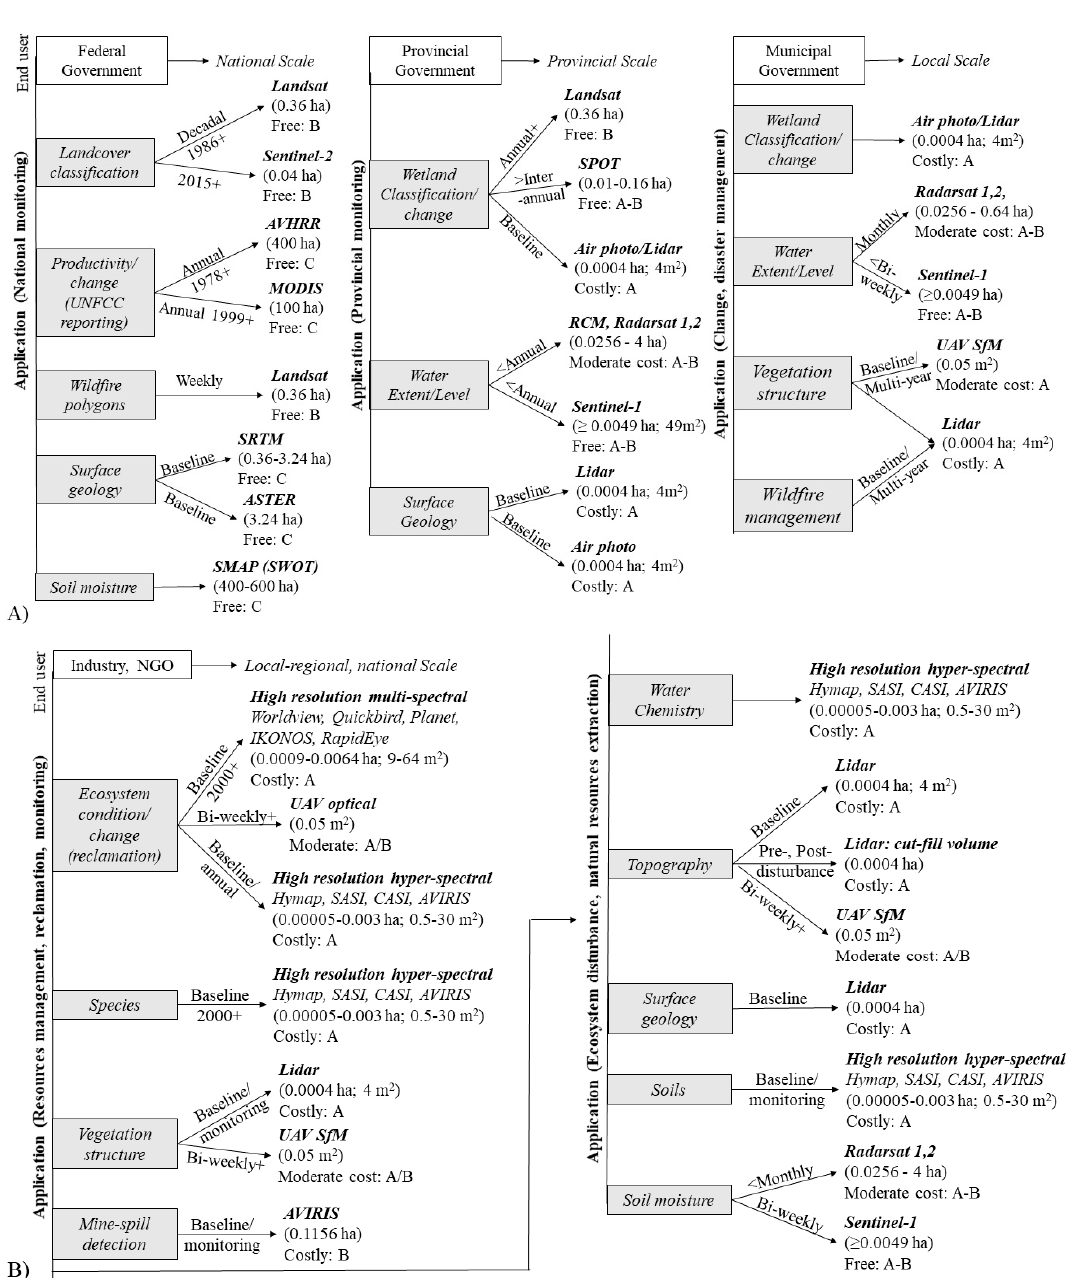
Figure 9. Use of remote sensing optimal sensors for common wetland-related applications of ( A ) government agencies, including National (left column), Provincial (middle column), and Municipal governments (right column), and ( B ) industry and non-governmental organisations (NGOs) end-users across various scales. Parentheses represent the minimum mapping unit for 2 x 2 pixels (in hectares and square meters for small areas) per sensor, followed by cost of acquisition ranking (Free, Moderate cost, High cost), and accuracy ranking, where A = highest accuracy, B = moderate accuracy, C = lowest accuracy.